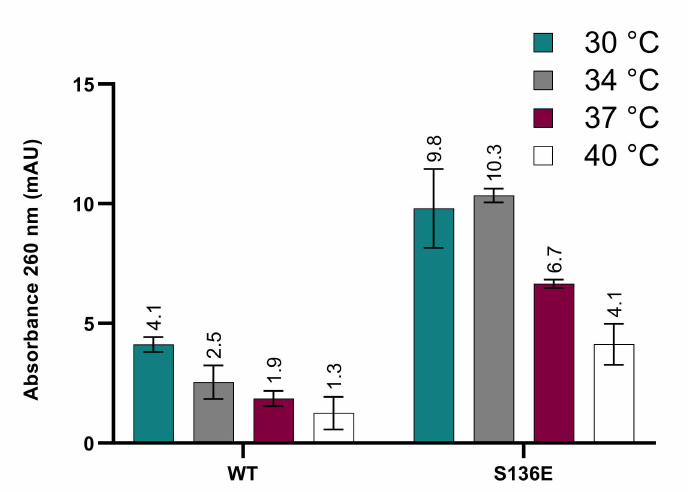
Figure 2. Hydrolysis rates of standardized PET discs over 24 h by S136E PETase variant and wild-type enzyme at a concentration of 100 nM over a range of relevant temperatures. Error bars represent the standard deviation of triplicate measurements. Absorbances are based on a path length of 1